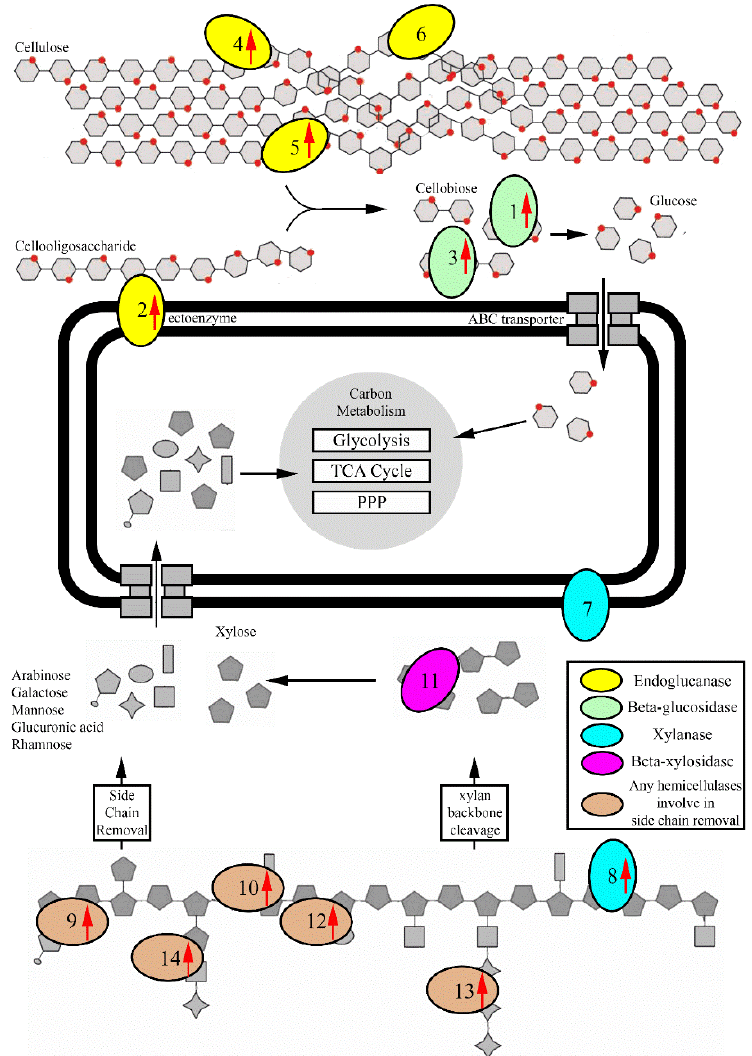
Figure 6. Illustration of (hemi-)cellulolytic hydrolysis of strain RA. 1–14: Selected enzymes listed in Table 5. Please refer to Table 5 for the complete protein names, family, and fold change of each enzyme. The red arrows indicate the upregulated genes when strain RA grows on MB supplemented with beechwood xylan.